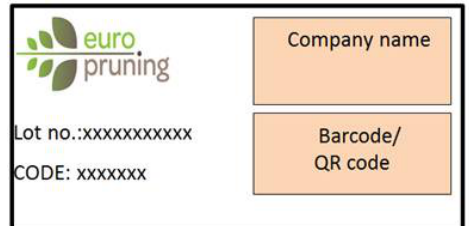
Figure 10. Sample of label indicating appearance of company name with its identification code, lot number of ordered biomass product, and QR code.